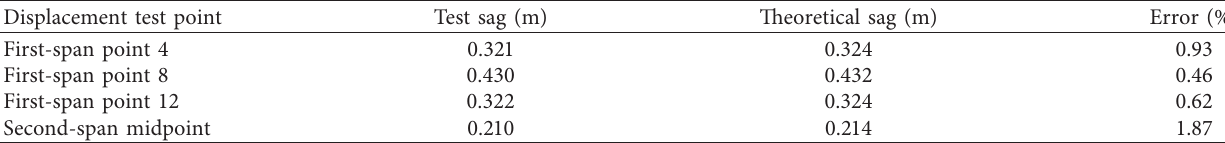
Table 2: Comparison of test sags and theoretical sags.